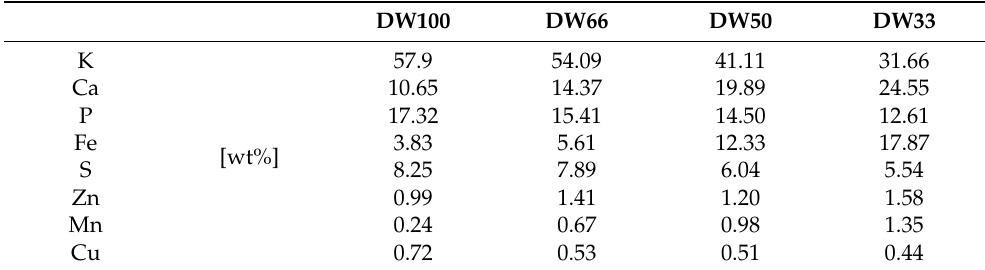
Table 4. Major nutrient contents of